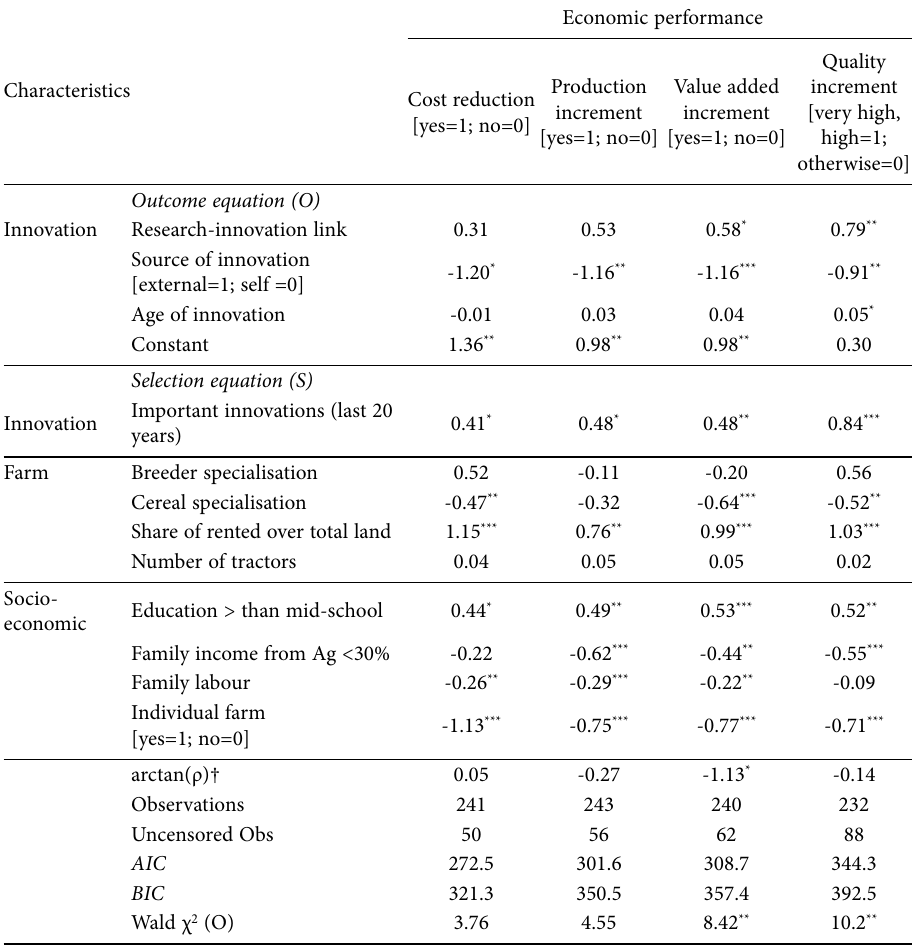
Table 9. Probit performance model with sample selection.